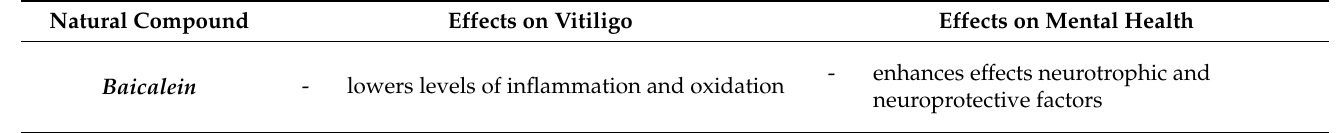
Table 1. Natural compounds tested both on vitiligo and mental health issues with respective effects. Natural